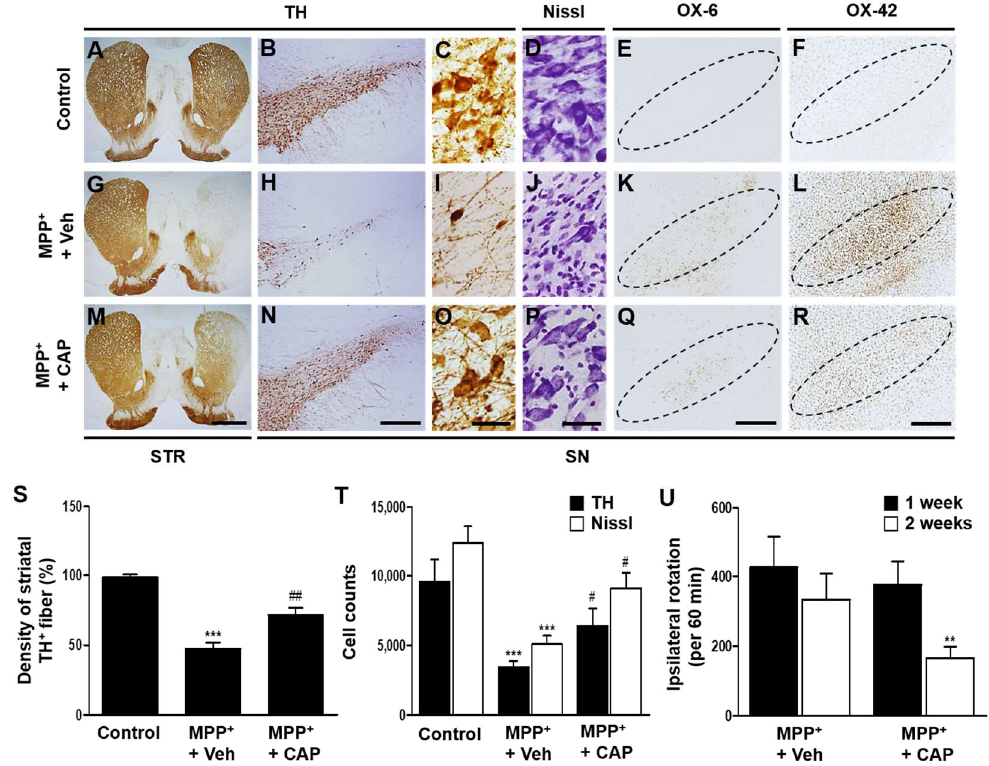
Figure 1. TRPV1 activation by capsaicin produces DA neuroprotection and reduces microglial activation in vivo in MPP + -lesioned rat. MPP + was unilaterally injected into the rat medial forebrain bundle (MFB) followed by intraperitoneal (i.p.) treatment of capsaicin (CAP: 1 mg/kg) or vehicle (Veh) at 8 days post MPP + injection and a continuous single injection per day for 7 days. Rats were transcardially perfused after the last amphetamine-induced rotation experiment. ( A – R ) Photomicrographs of TH + fibers ( A , G , M ) in the striatum (STR), and TH + ( B , C , H , I , N , O ), Nissl + ( D , J , P ),